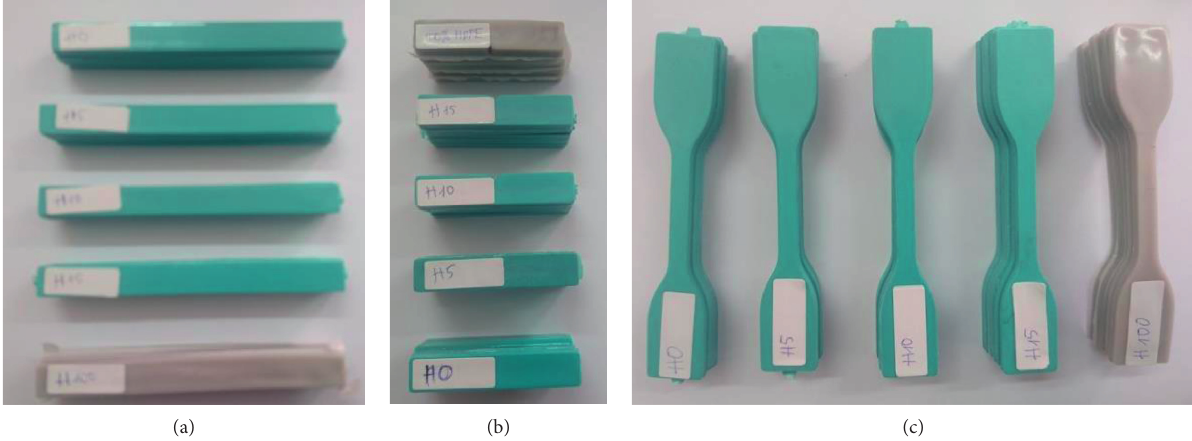
Figure 7: Specimen of the tensile test, flexural strength test, and Charpy impact test: (a) flexural strength samples, (b) Charpy impact samples, and (c) tensile test